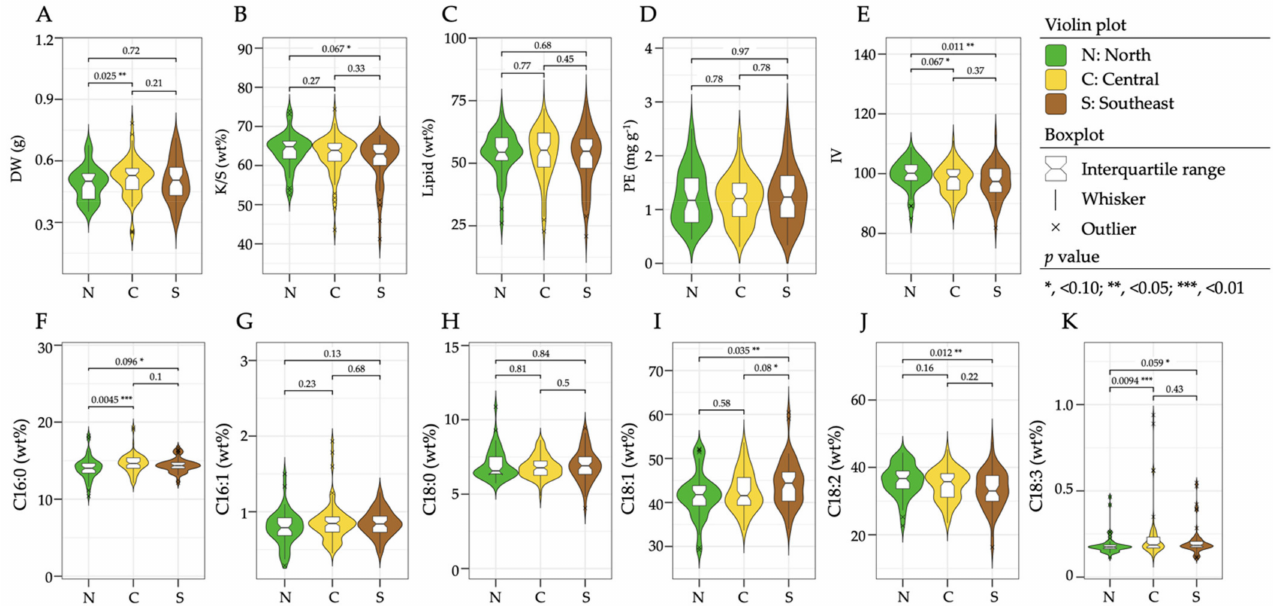
Figure 3. Violin/box plot analysis of the geographical diversity of seed chemical compositions among Botswanan Jatropha accessions. The three accession groups (North (N), Central (C), and Southeast (S)) defined in Figure 1 were used for the analysis. The estimated distributions of the populations are displayed as colored violin plots for the ( A ) DW, ( B ) K/S gravimetric ratio, ( C ) total lipid and ( D ) PE content, ( E ) IV, and the ( F ) C16:0, ( G ) palmitoleic acid (C16:1), ( H ) C18:0, ( I ) C18:1, ( J ) C18:2, and ( K ) α -linolenic acid (C18:3) content. The notched box-and-whisker plots represent the median, interquartile range, and variability, and their outliers are shown as crosses. The significance of the difference between groups was calculated using the Wilcoxon test, and their p values are provided above the brackets. Significant differences with p values below 0.10, 0.05, and 0.01 are expressed by *, **, and ***,